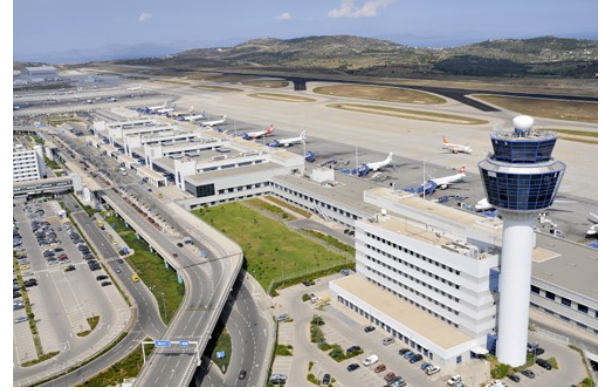
Figure 1: Athens International Airport (AIA)